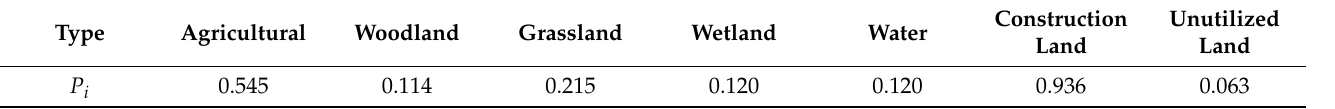
Table 2. Parameter of the degree of land-use of different types ( P i